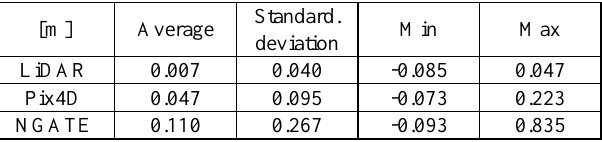
Table 3: Statistics of height difference between DTM’s and